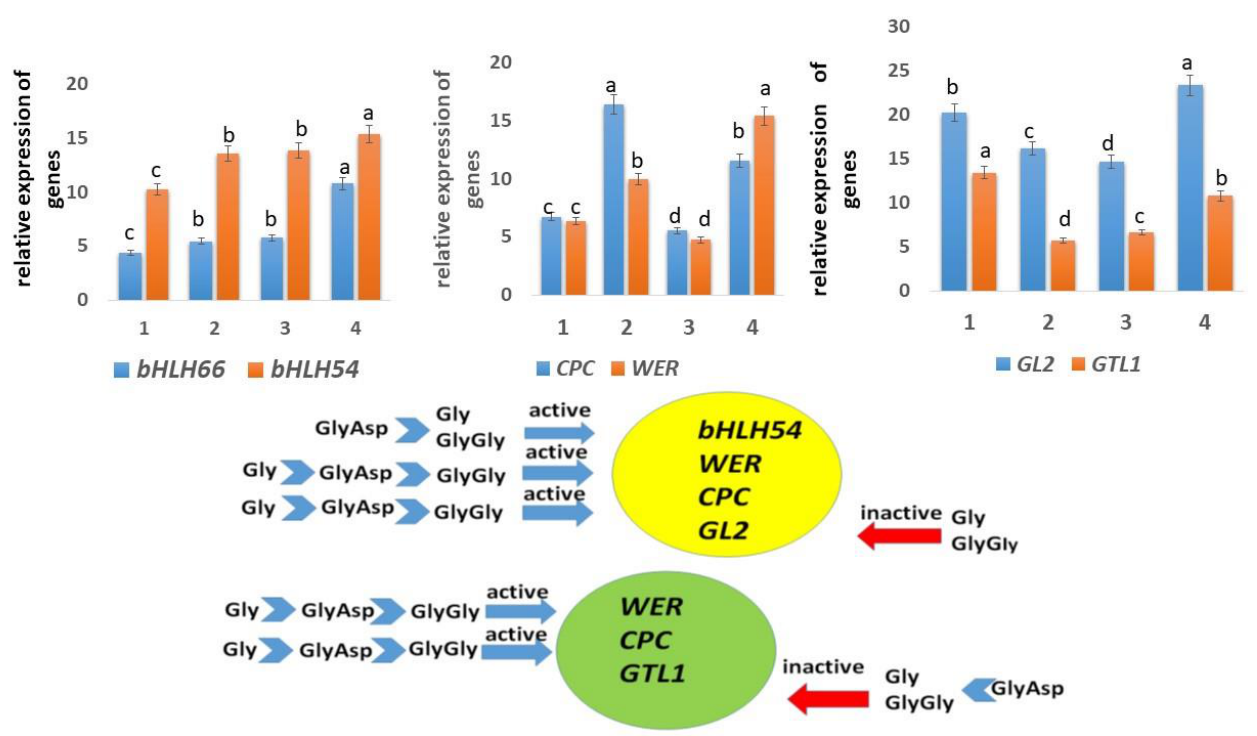
Figure 4. Relative expression levels of genes in tobacco seedling roots. 1—control; 2—Gly; 3—GlyGly; and 4—GlyAsp. Data represent mean ± standard deviation. The diagram below indicates the activation or repression of genes in the presence of Gly and dipeptides. Standard deviations are shown according to significant value, p < 0.05. Different letters above the bars indicate significantly different values.